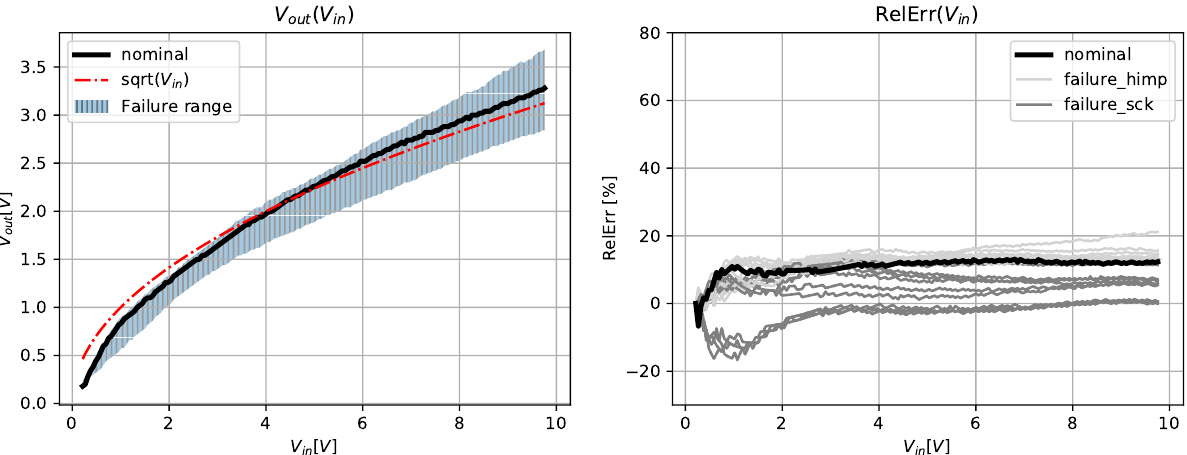
Figure 13. The measured voltage response of a real-world prototype failure-resilient square root circuit. ( Left ) The complete output range where the red (dash-dot) curve represents the ideal square root function, the black (solid) curve represents the failure-free circuit, and the gray area represents the range of responses with all possible single diode failures. ( Right ) Relative deviations from the −√ V in ) . A nominal design offset is subtracted from √ ideal square root function ( RelErr ( V in ) = V out V in ) max ( V out , V out for RelErr ( V in ) representation. Stuck-open failures are drawn in dashed lines while stuck-short failures are drawn in dotted